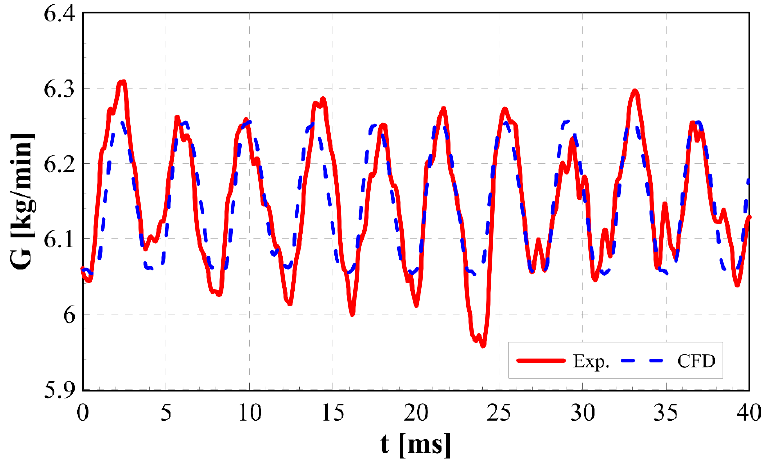
Figure 10. Comparison between the numerical and the experimental flowrates (1200 rpm, 6.5 bar— Configuration 2).